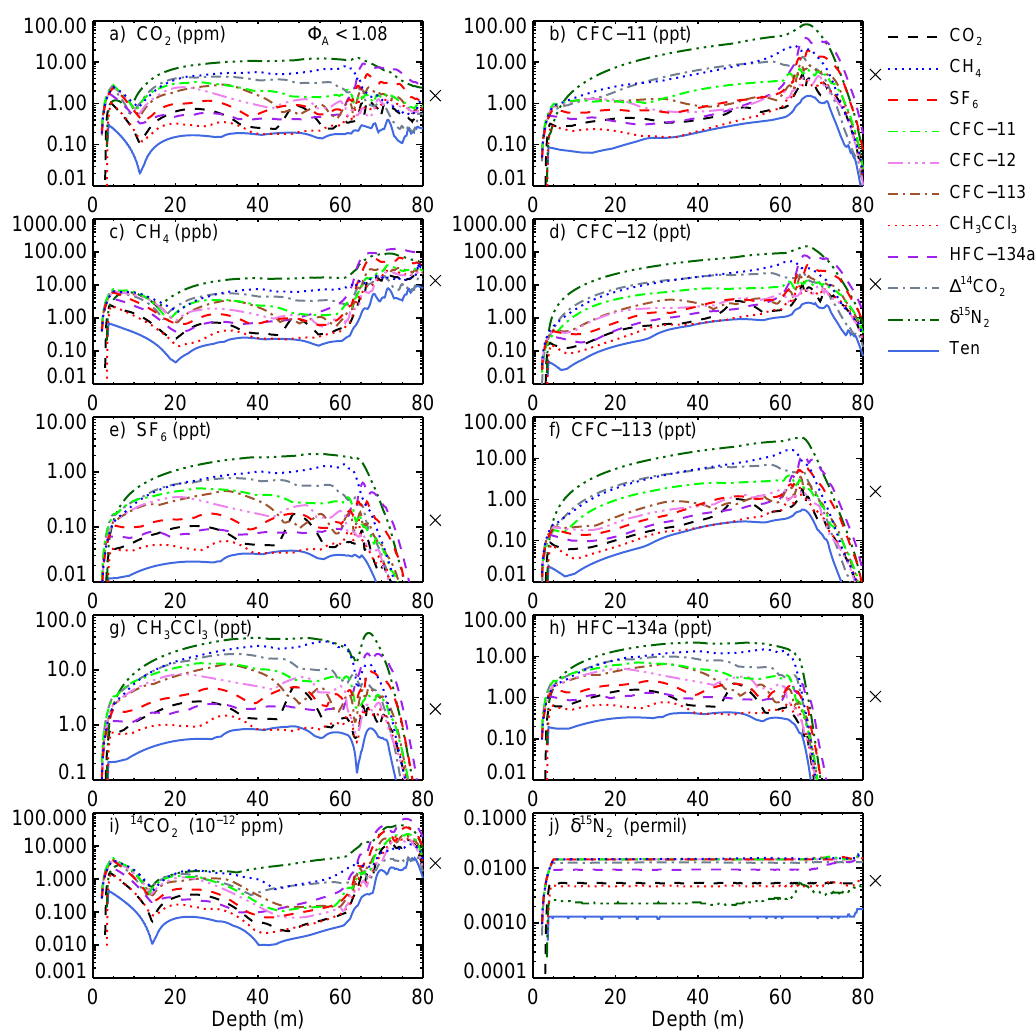
Fig. 4. Range of concentration for all 10 tracers, for all accepted solutions ( 8 A < 1 . 08) with Synthetic A observations, with each tracer used for calibration on its own and Subset Ten described earlier. Each panel shows the range calculated for one tracer, and each line in that panel corresponds to a different tracer (or Subset Ten) used for calibration. To the right of each panel, the cross symbol shows 2 σ (twice the standard deviation of the error applied to the observations of that